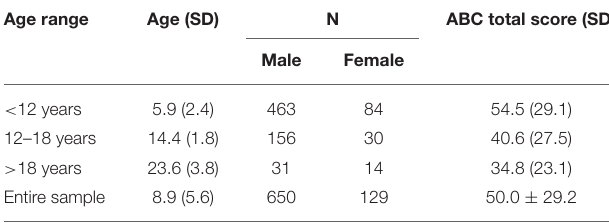
TABLE 1 | Normative data of the sample.